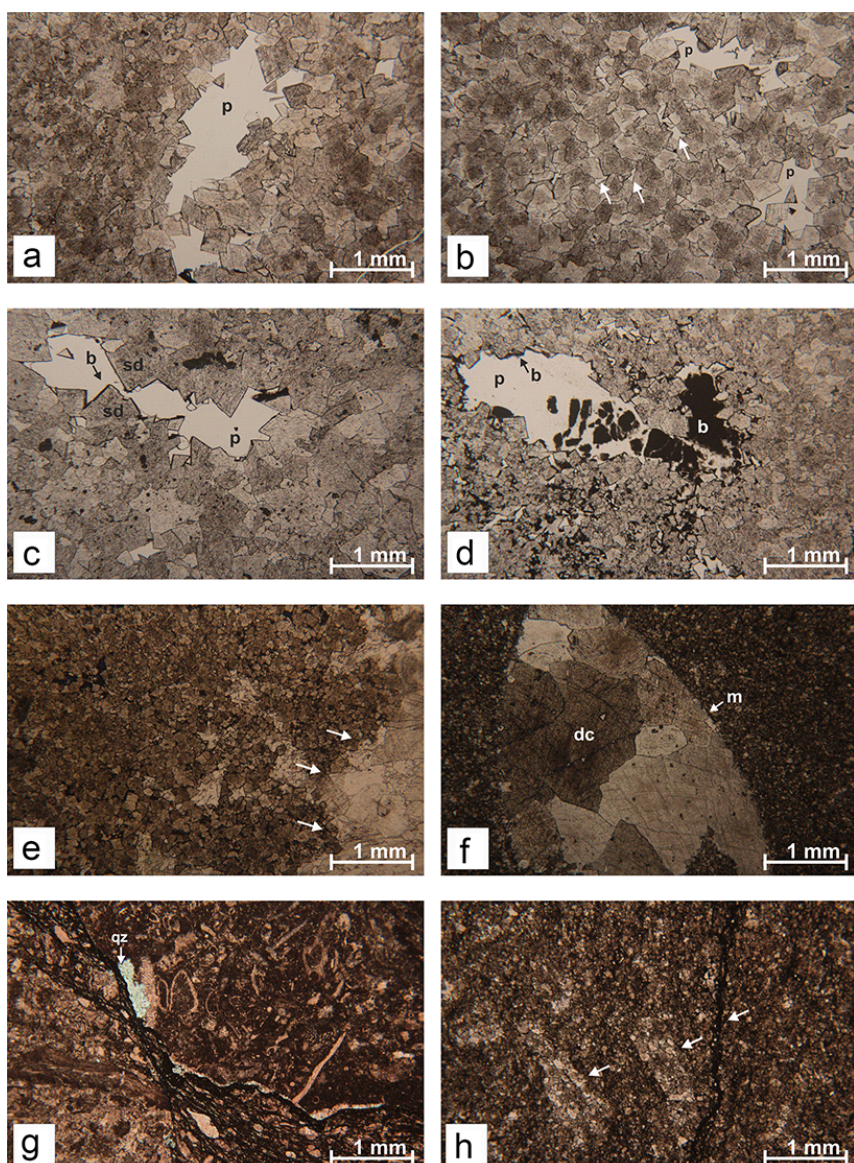
Bigoray Member (3173m b.g.l.). (g) Possible residual coral on the left and shell fragments (possibly from gastropods) in micritic